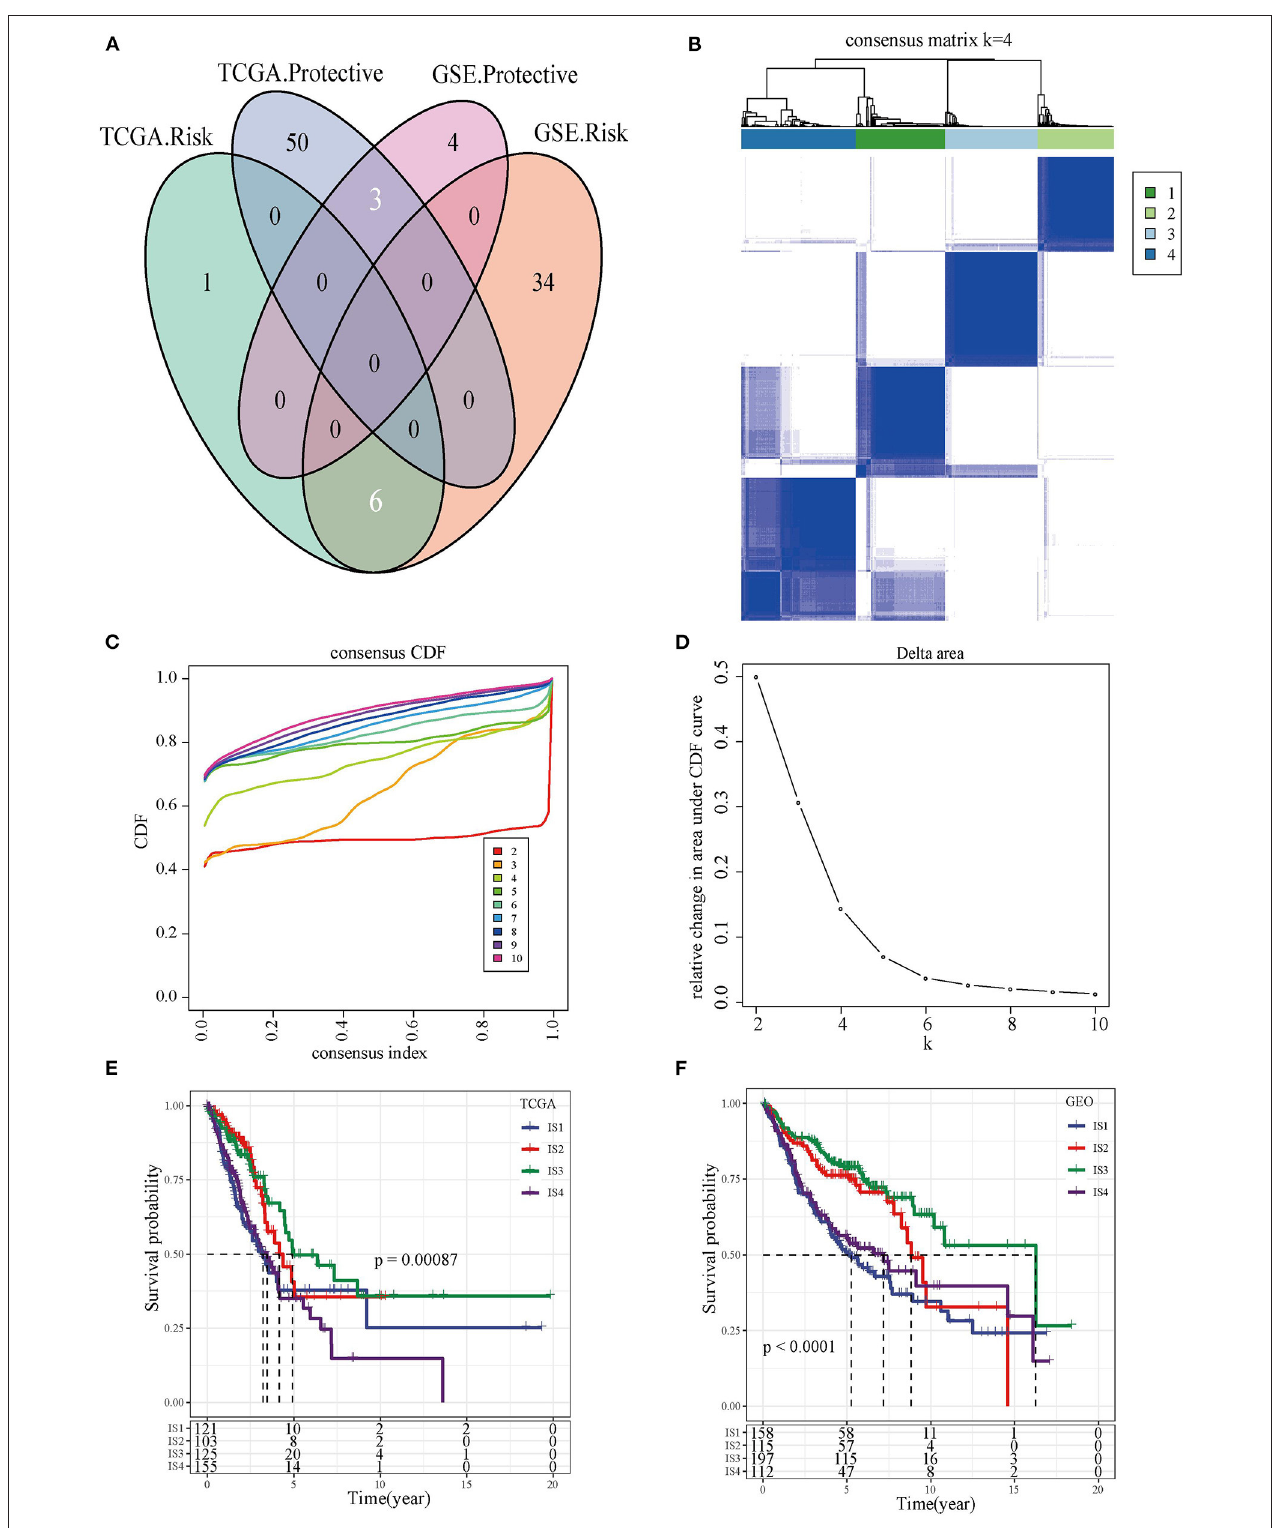
FIGURE 1 | The immune subtypes and survival analysis. (A) The Venn diagram showed the intersection of immune cell signatures related to LUAD prognosis in TCGA and GEO databases. (B) Heat map of the consensus matrix when the total samples are clustered into four ISs. (C) Relationship between the relative changes in the area under the CDF curve and consensus index. (D) Heat map of the consensus matrix when the LUAD was clustered into four immune subgroups. (E) Kaplan-Meier survival curve showed the OS of four types of ISs patients in TCGA. (F) Kaplan-Meier survival curves of four types of ISs patients in GEO.